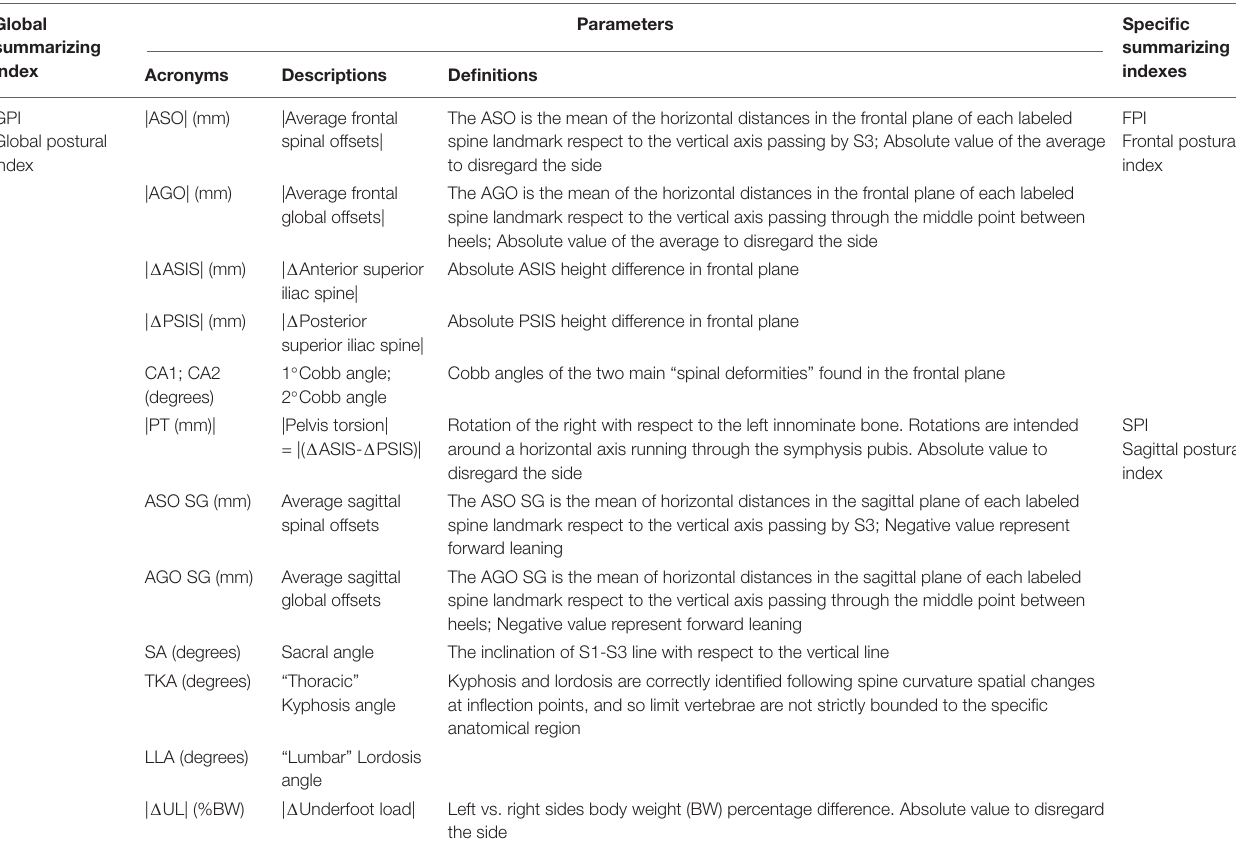
TABLE 2 | List of considered parameters (definitions and corresponding acronyms) for indifferent orthostasis (IO) vs. instinctive self-correction (ISCO) comparison and summarizing indexes. Global